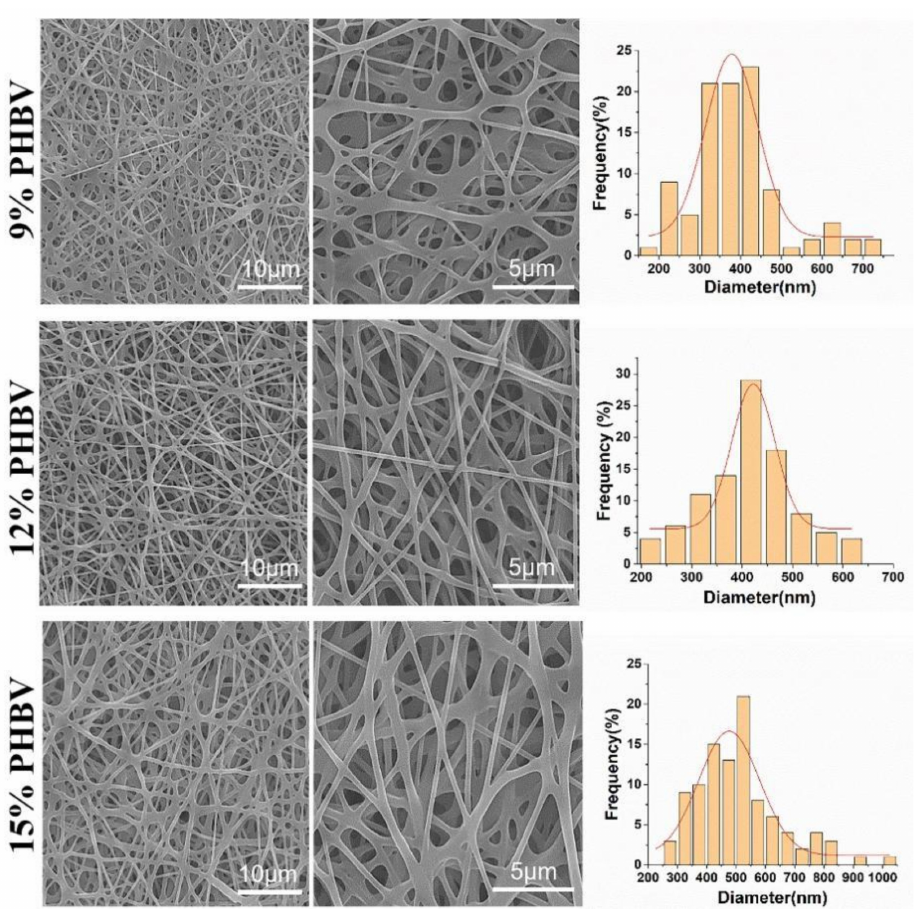
Figure 3. SEM images and corresponding diameter distribution analysis of PHBV nanofiber scaffolds produced from three different polymeric concentrations, i.e., 9%, 12%, and 15% ( w / v